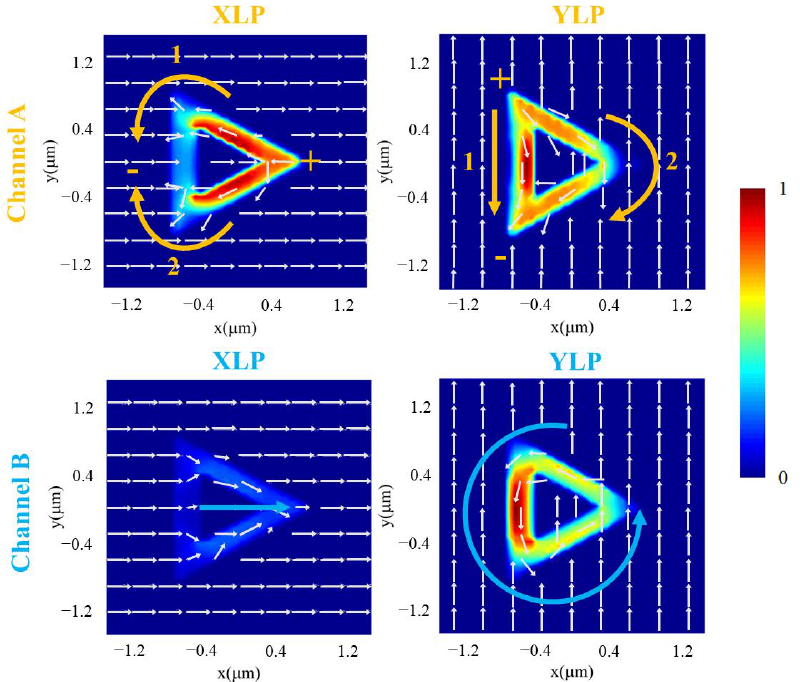
Figure 5. Surface current distributions with different channels and polarization angles. White arrows represent the directions of the electric field of the unit cell. Yellow arrows represent the directions of the currents in channel A. Blue arrows represent the directions of the currents in channel B.